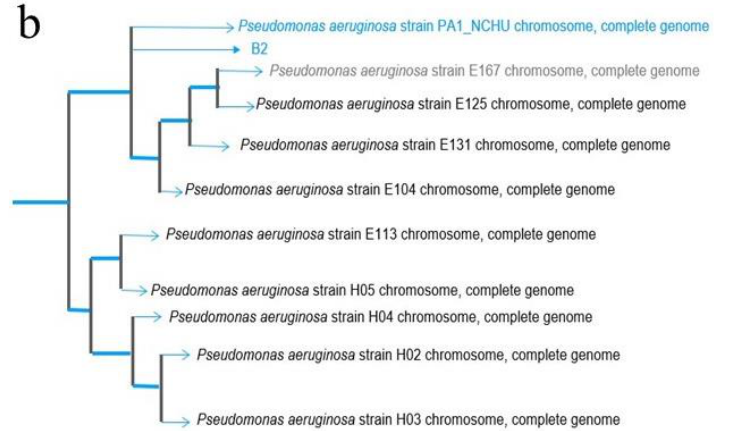
Figure 1. Phylogenetic tree of ( a ) Enterococcus faecalis SUCR1 and ( b ) Pseudomonas aeruginosa PA1_NCHU islated from cow dung and soil sampes, respectively.